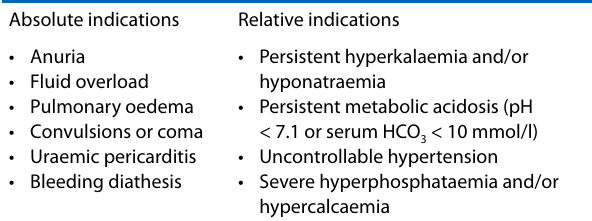
Table 3: Maintenance fluids in children 25 Child maintenance fluid requirement volumes